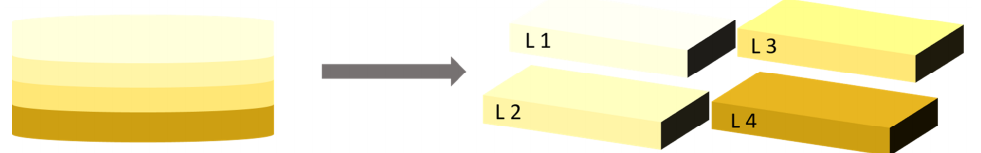
Figure 1. Scheme of layer structure of multilayer zirconia blanks and specimen preparation from each layer. L1 = enamel layer, L2 = first transition layer, L3 = second transition layer, L4 = dentin layer.